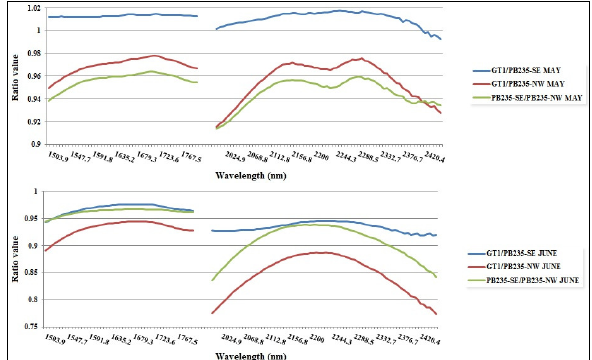
Figura 20. Ratios among spectra of the Rubber trees stands (GT1, PB235-SE and PB235-NW) from 1,300 to 2,500nm, for May and June, in leaf